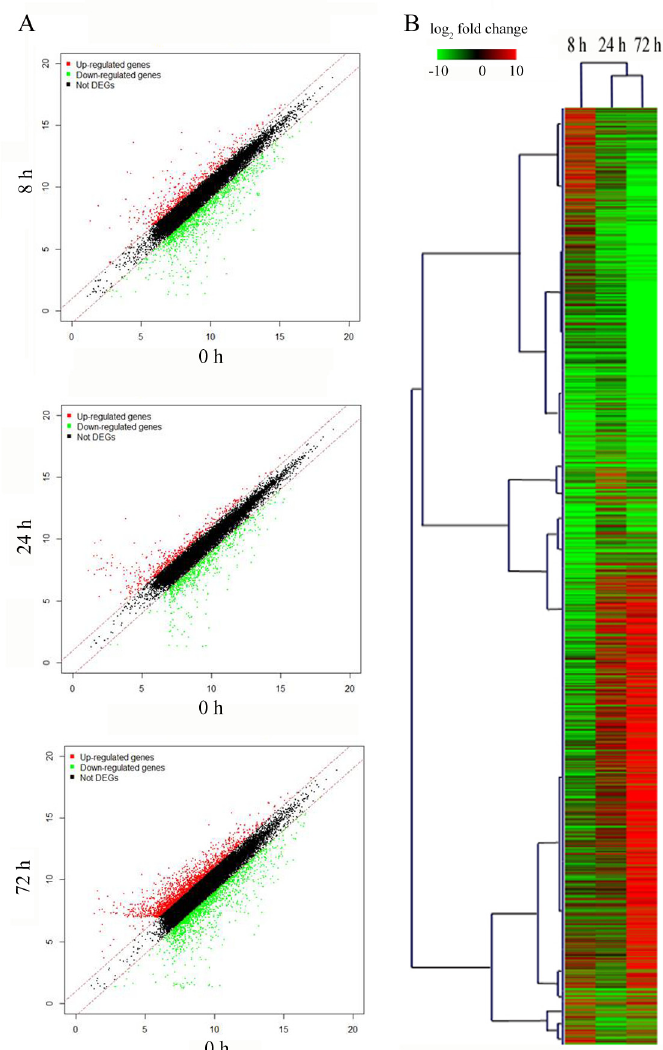
Fig 2. Gene expression detected by microarray after different periods of low-K stress. A) Scatter plots of the normalized signal intensities of approximately 21516 genes on the microarray. Log 2 intensities for each spot on the microarray are plotted on the x and y axes with signals from root tips stressed for 0 h and 8 h, 0 h and 24, and 0 h and 72 h. The diagonal lines represent fold change cutoffs of 2. The red spots represent up- regulated genes and the green spots indicate down-regulated genes. B) Hierarchical cluster analysis of genes which were responsive to low-K stress. Genes are displayed using different colors, and relative expression levels are illustrated by a color gradient from low (green) to high